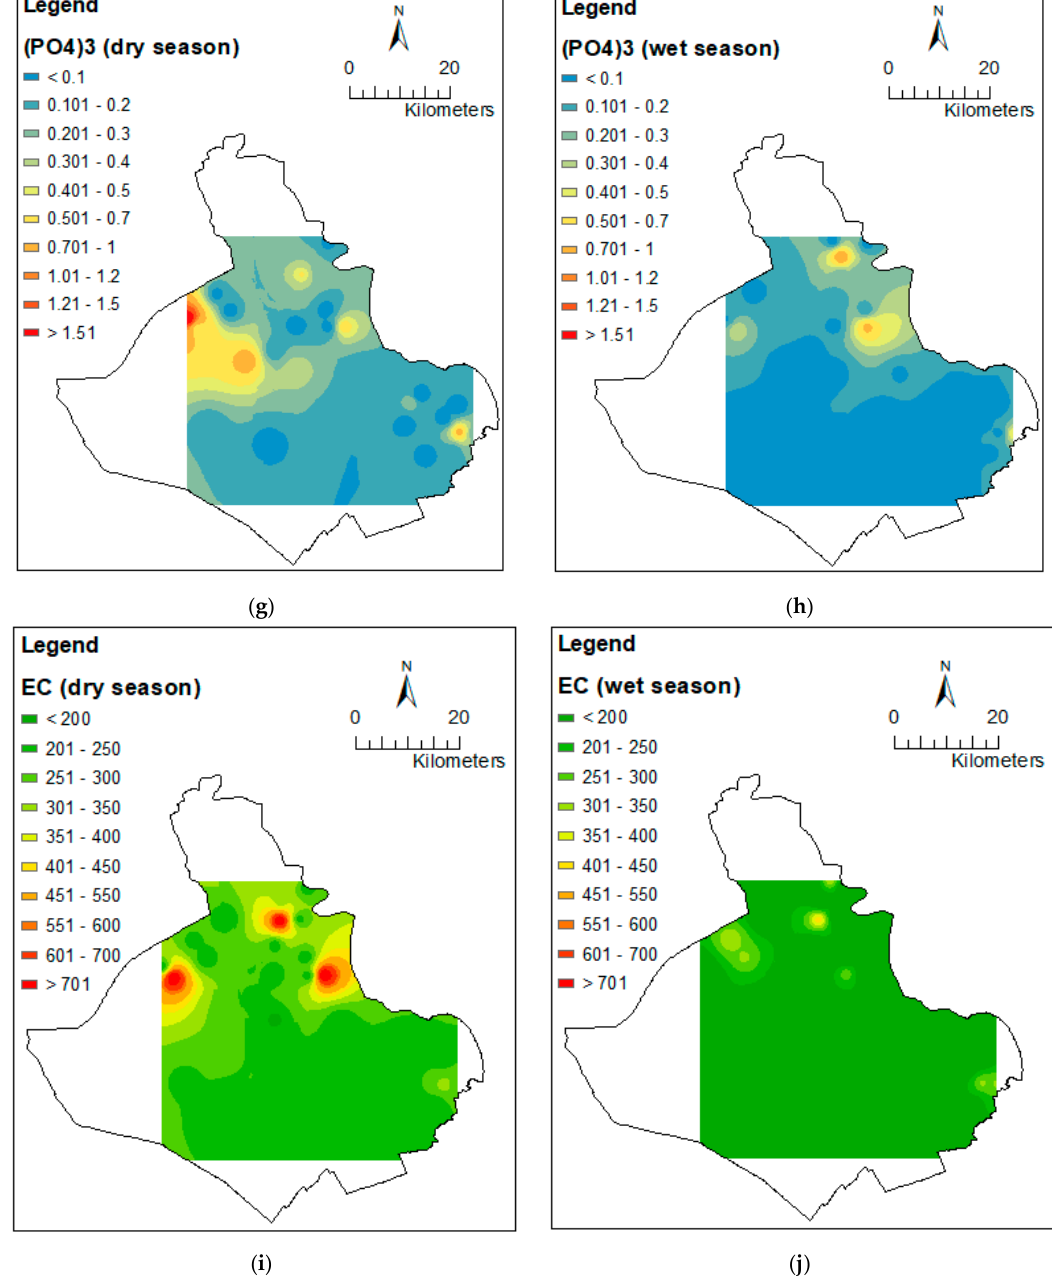
Figure 8. Concentrations of COD displayed by IDW: ( a ) in the dry season, and ( b ) in the wet season, An Giang province, 2017. Concentrations of NH 4 + displayed by IDW: ( c ) in the dry season, and ( d ) in the wet season, An Giang province, 2017. Concentrations of NO 3 − displayed by IDW: ( e ) in the dry season, and ( f ) in the wet season, An Giang province, 2017. Concentrations of PO 4 − displayed by IDW: ( g ) in the dry season, and ( h ) in wet season, An Giang province, 2017. Concentrations of EC displayed by IDW: ( i ) in the dry season, and ( j ) in wet seasons An Giang province, 2017.